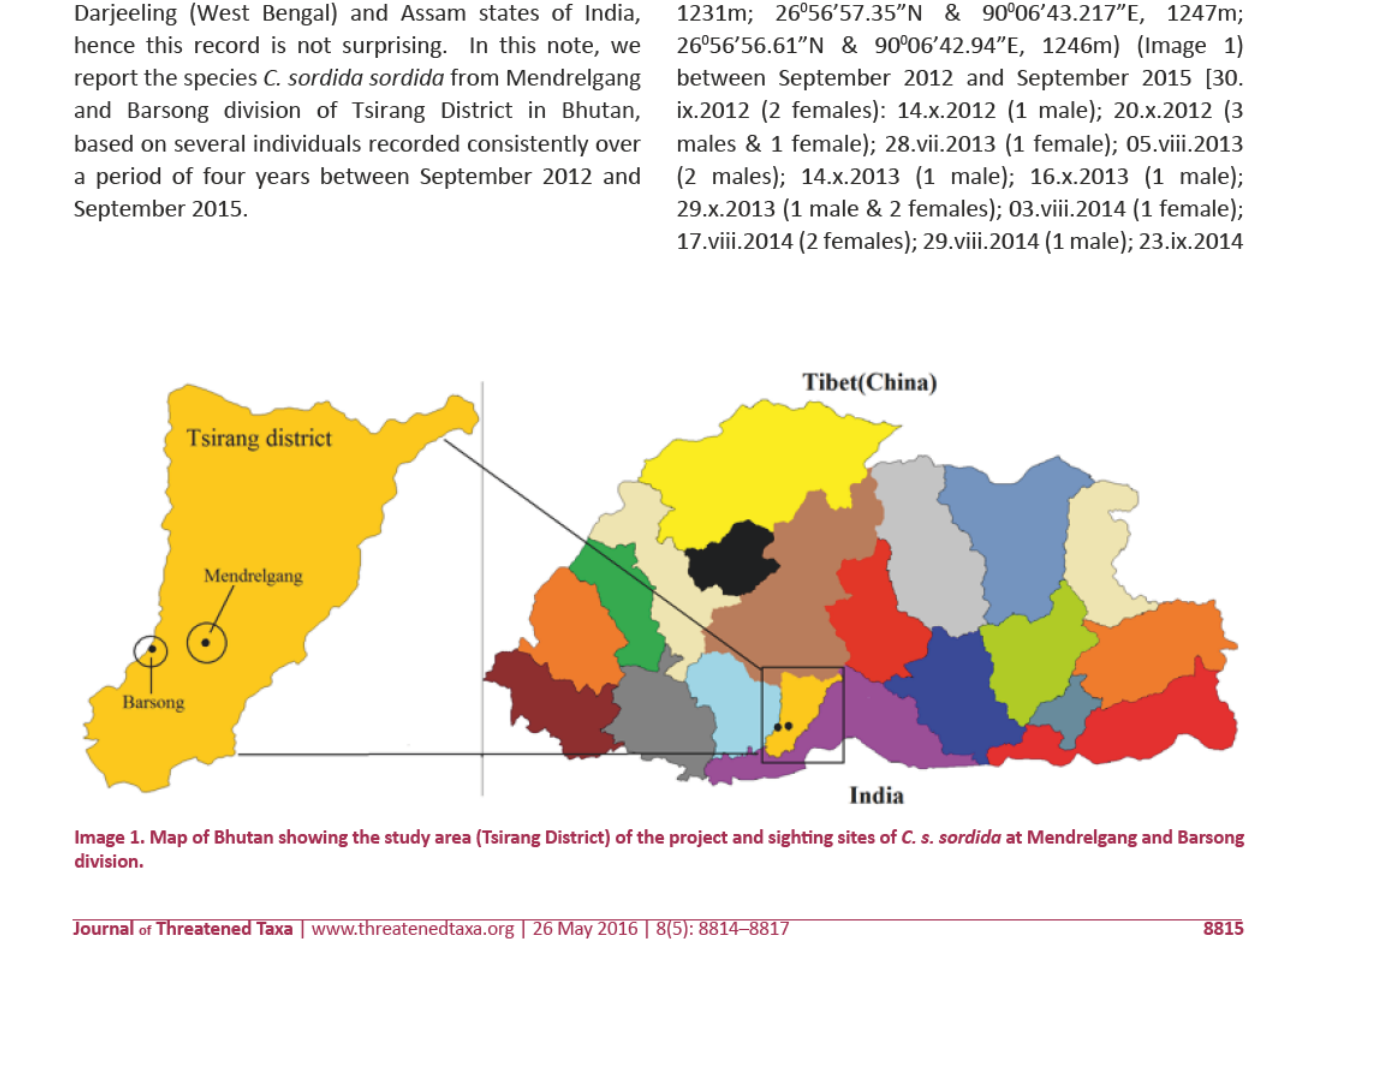
Image 1. Map off Bhuttan showfing tthe sttudy area (Tsfirang Dfisttrfictt) off tthe projectt and sfighfing sfittes off C. s. sordfida att Mendrelgang and Barsong